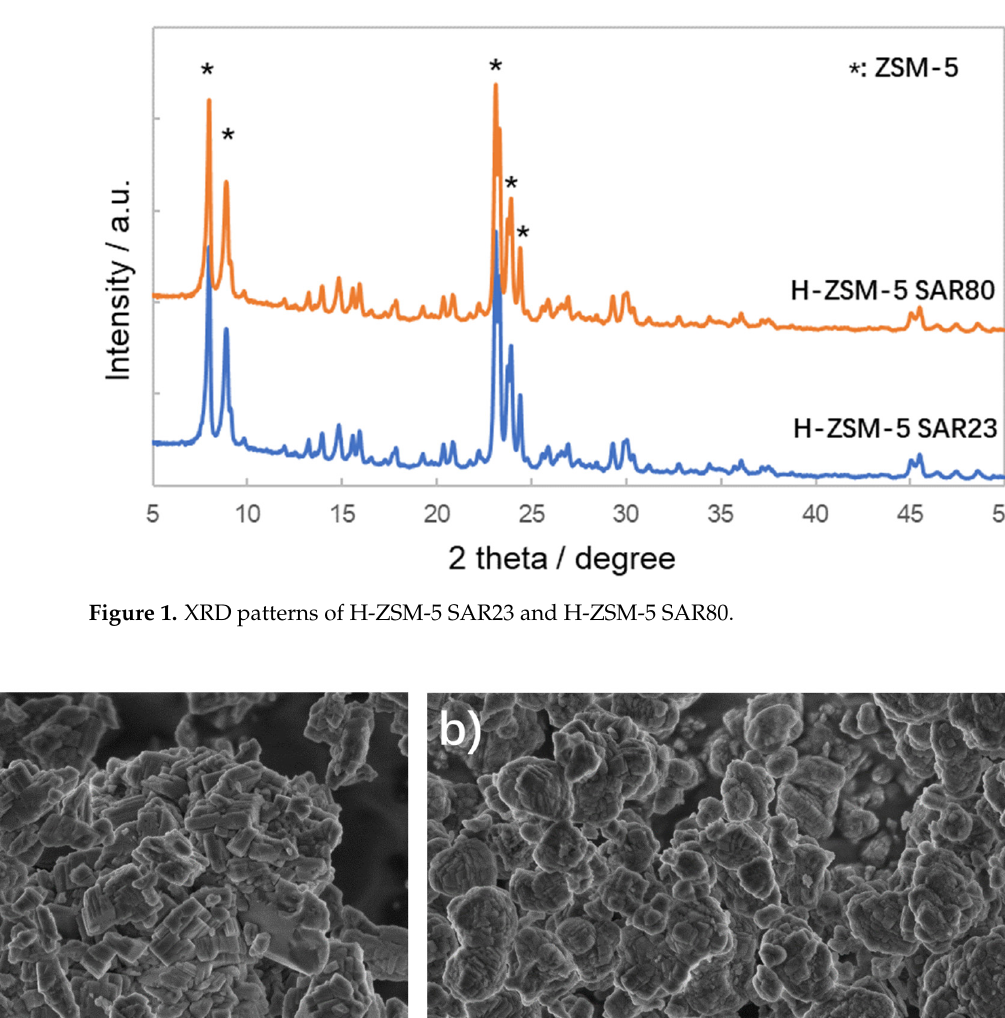
Figure 2. SEM images: ( a ) H-ZSM-5 SAR23; ( b ) H-ZSM-5 SAR80.